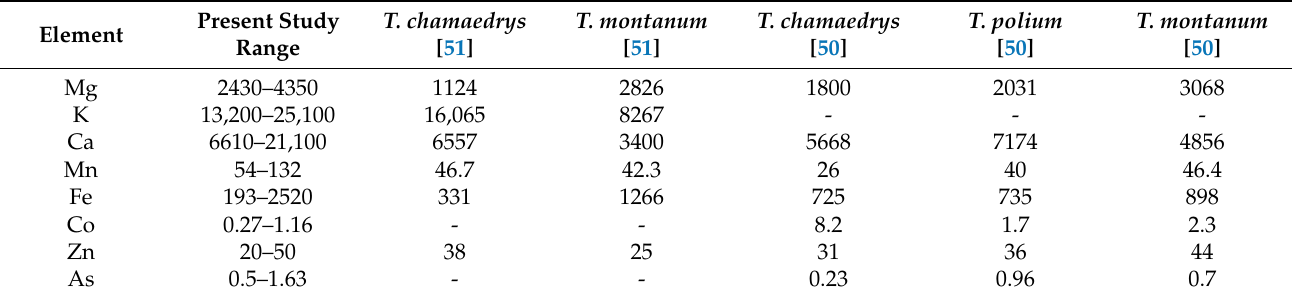
Table 3. Benchmarking of NAA analysis of some Teucrium spp. of Bulgarian [49,50], Serbian [50,51], and Moldavian origins (mass fraction in mg/kg).